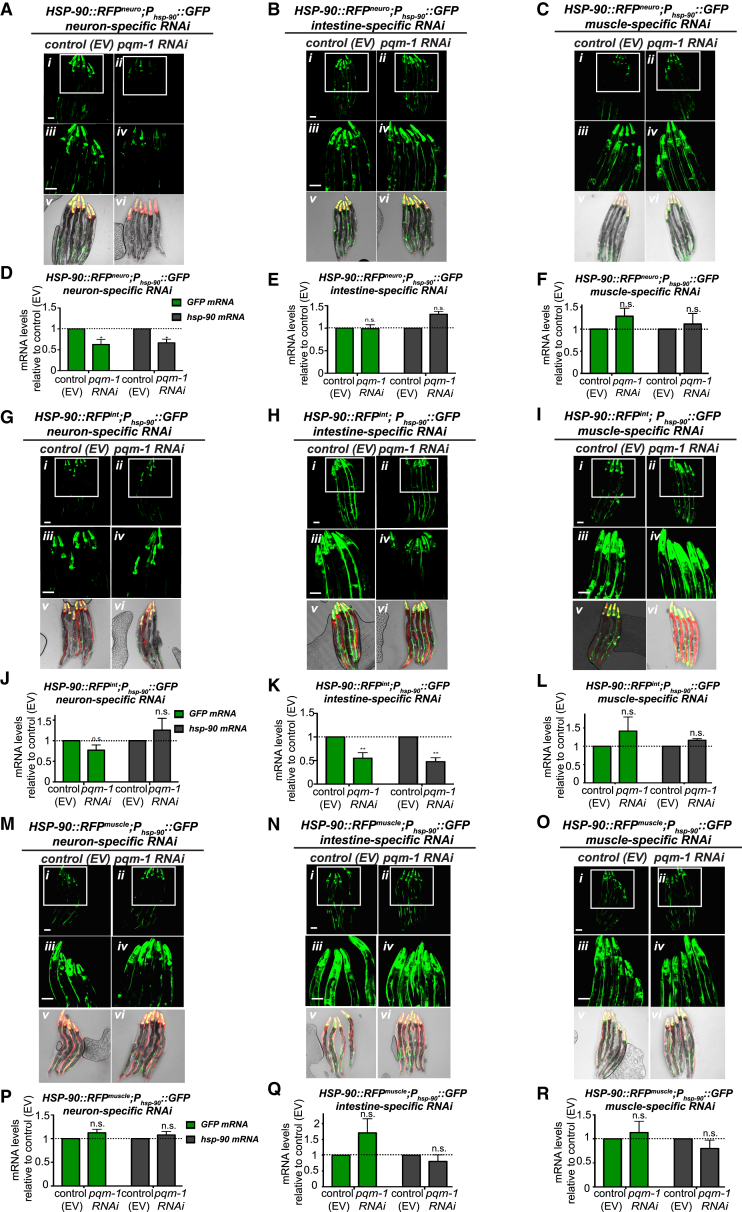
PQM-1 Is Required in the Neurons in HSP-90::RFPneuro and in the Intestine in HSP-90::RFPint to Induce TCS(A–C) Expression of the Phsp-90::GFP transcriptional reporter in HSP-90::RFPneuro during tissue-specific control or pqm-1 RNAi in neurons (A), intestine (B), or bodywall muscle (C).(D–F) Transcript levels of GFP and hsp-90 in HSP-90::RFPneuro;Phsp-90::GFP during neuron-specific (D), intestine-specific (E), and muscle-specific (F) control (EV) or pqm-1 RNAi. ∗p < 0.05; ns, non-significant. Bar graphs represent combined mean values of three independent experiments. Error bars represent ± SEM.(G–I) Expression of the Phsp-90::GFP transcriptional reporter in HSP-90::RFPint adults during tissue-specific control RNAi (EV) or pqm-1 RNAi in neurons (G), intestine (H), or bodywall muscle (I).(J–L) Transcript levels of GFP and hsp-90 during neuron-specific (J), intestine-specific (K), or muscle-specific (L) control (EV) or pqm-1 RNAi in HSP-90::RFPint;Phsp-90::GFP.(M–O) Expression of the Phsp-90::GFP transcriptional reporter in HSP-90::RFPmuscle adults during tissue-specific control RNAi (EV) or pqm-1 RNAi in neurons (M), intestine (N), or bodywall muscle (O).(P–R) Transcript levels of GFP and hsp-90 mRNA in HSP-90::RFPmuscle;Phsp-90::GFP during neuron-specific (P), intestine-specific (O), or muscle-specific (R) control (EV) or pqm-1 RNAi. ∗p < 0.05; ns, non-significant. Bar graphs represent combined mean values of three independent experiments.Error bars represent ± SEM (A–C, G–I, and M–O). Scale bar, 50 μm.See also Figures S5 and S6.